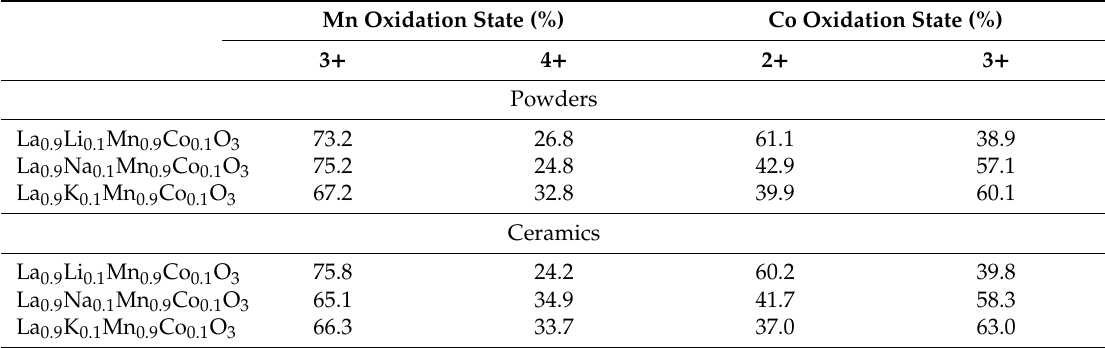
Table 2. Oxidation state of Mn and Co ions in synthesized powders and